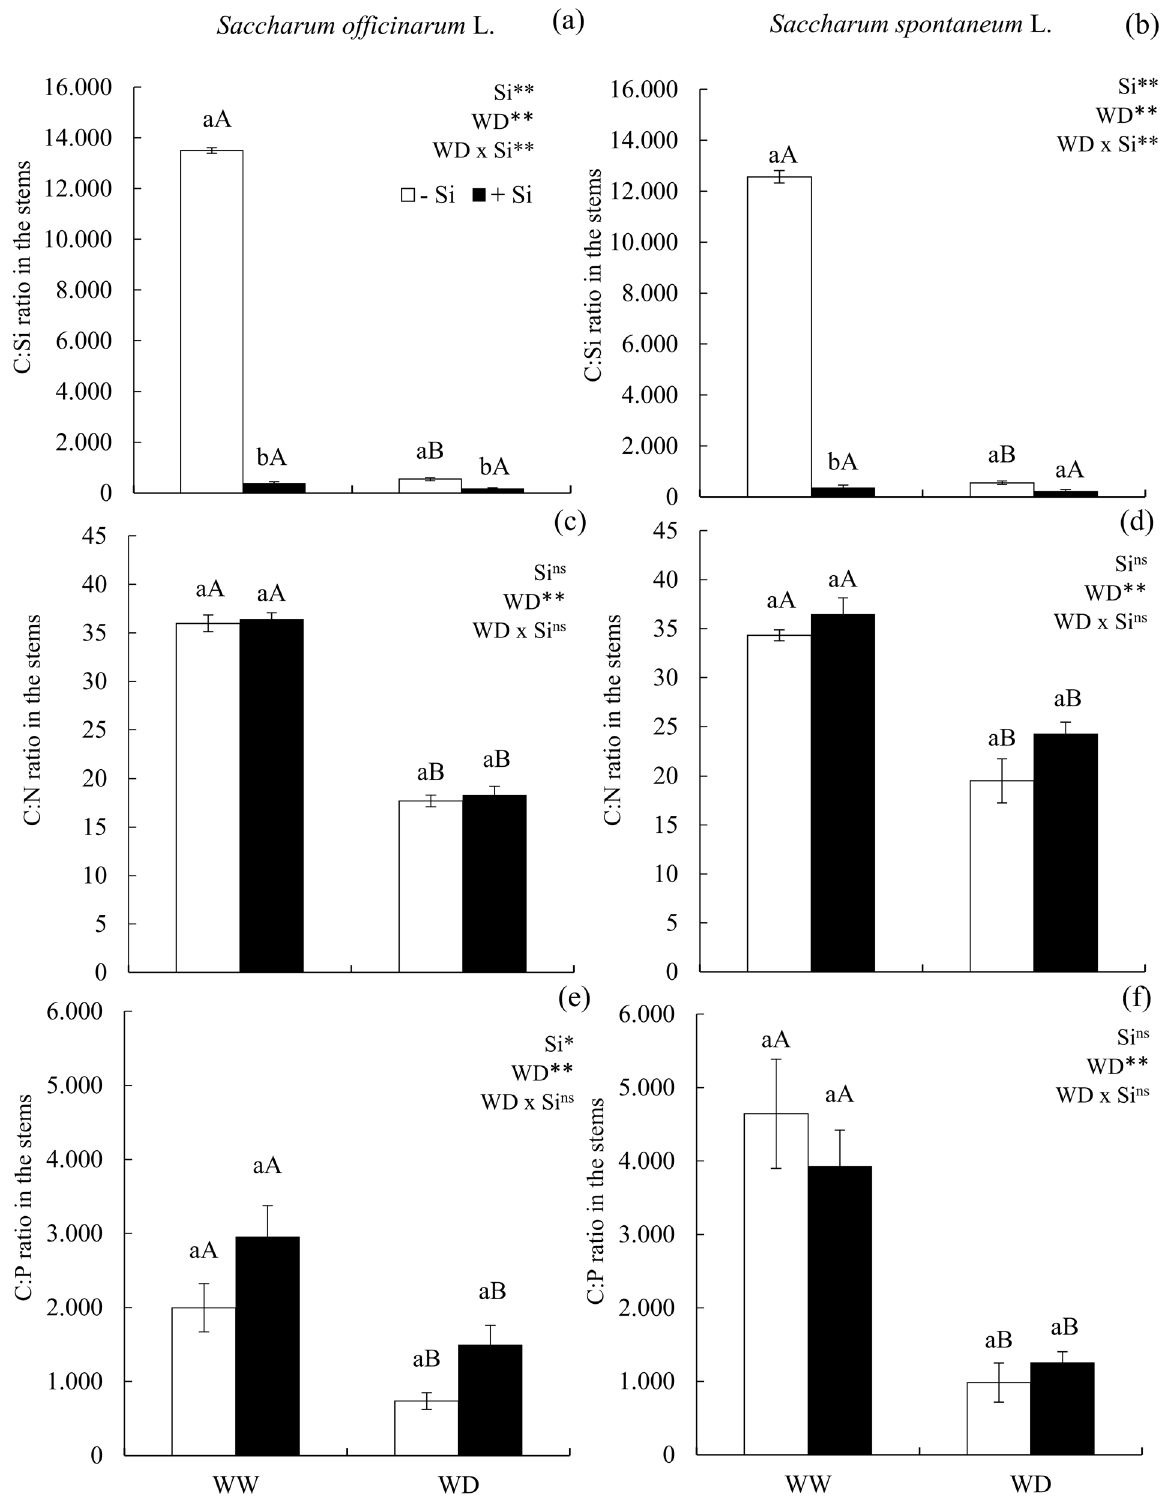
Figure 3. C:Si ration ( a , b ) C:N ration ( c , d ) and C:P ration ( e , f ) in the stems of ratoon of sugarcane ( Saccharum officinarum L.) ( a , c , e ) and energy cane ( Saccharum spontaneum L.) ( b , d , f ) cultivated without water deficit-WW (70% of soil water retention capacity—WRC) and with water deficit-WD (30% of WRC) without (− Si) and with (+ Si) application of Si via fertigation associated with leaf spray. ** and *: significant at 1 and 5% probability, respectively; and ns not significant for main effects and interaction, by the F-test. Lowercase letters show differences in relation to Si and uppercase letters in relation to WD. Bars represent the standard error of the mean. Si × WD: